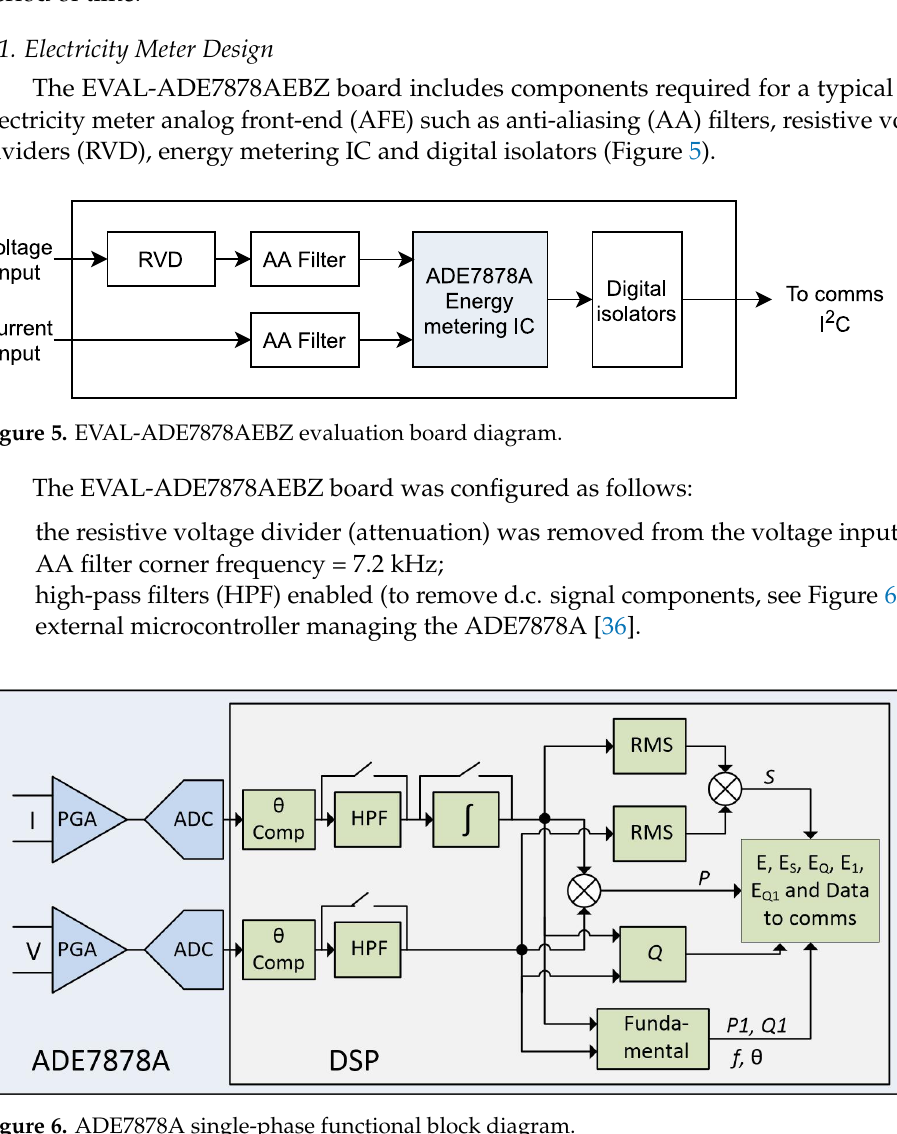
Figure 6. ADE7878A single-phase functional block